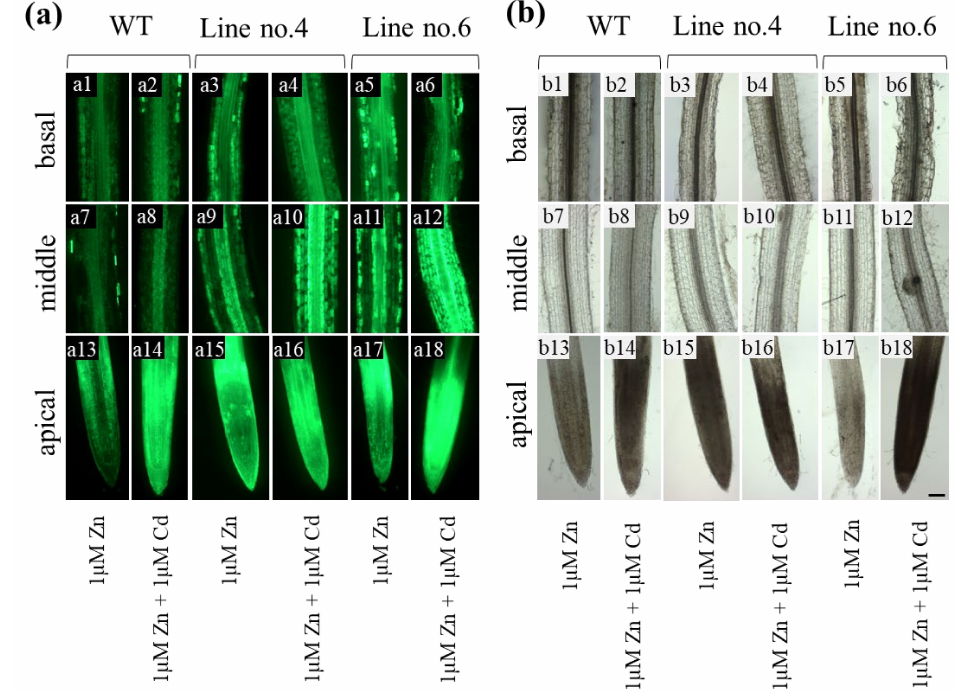
Figure 4. Zn distribution at the longitudinal sections through the apical, middle, and basal parts of the roots from wild-type and NtZIP4A / B -RNAi plants, grown under various Zn and Cd con- centrations, visualized by Zinpyr-1. 3.5-week-old plants of wild-type (WT) and NtZIP4A / B -RNAi lines (number 4 and number 6) grown in the quarter-strength Knop’s medium were exposed for 17 days to the control medium supplemented with 1 µ M Zn with or without 1 µ M Cd. Fluorescence microscope images of longitudinal sections through the apical, middle, and basal root parts ( a ). Representative pictures of the anatomical structure of the root parts at bright field ( b ). Plants grown at 1 µ M Zn ( a1 , a7 , a13 , a3 , a9 , a15 , a5 , a11 , a17 , b1 , b7 , b13 , b3 , b9 , b15 , b5 , b11 , b17 ); at 1 µ M Zn + 1 µ M Cd ( a2 , a8 , a14 , a4 , a10 , a16 , a6 , a12 , a18 , b2 , b8 , b14 , b4 , b10 , b16 , b6 , b12 , b18 ). Wild-type plants (WT); RNAi plant lines (number 4 and number 6). Magnification bars = 0.25